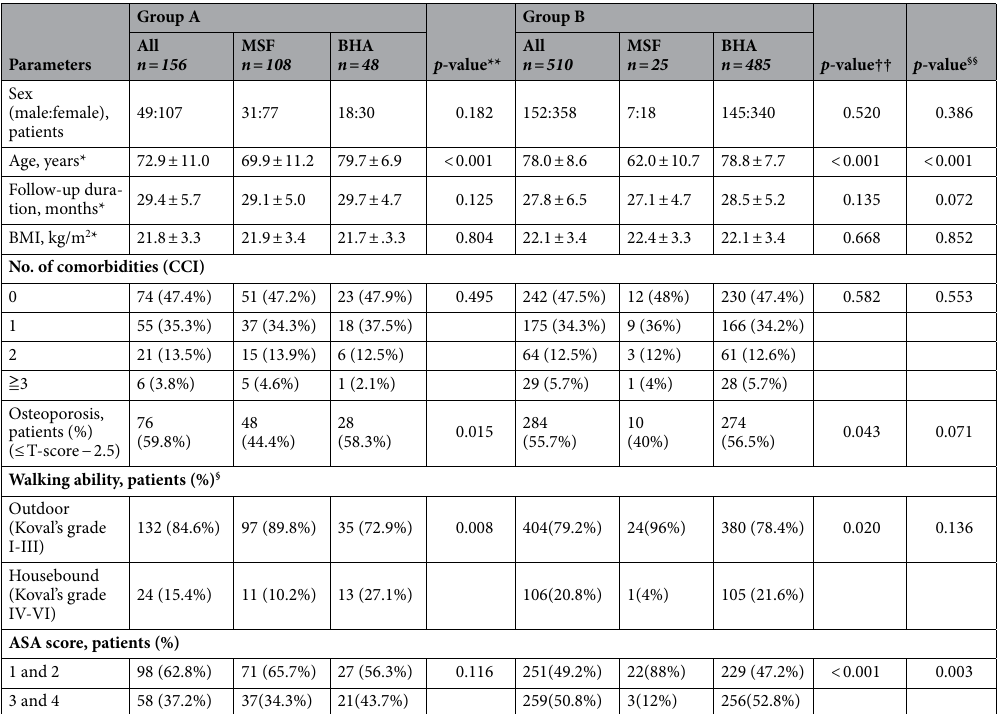
Table 1. Comparison of demographic data according to fracture pattern and type of surgery. *Expressed as average ± standard deviation. § Modified from Koval’s grade 15 . **Significance between MSF and BHA within Group A. †† Significance between MSF and BHA within Group B. §§ Significance between Group A and B. MSF, multiple screw fixation; BHA, cementless bipolar hemiarthroplasty; n , numbers; BMI, body mass index; ASA, American Society of Anesthesiologists; CCI, Charlson’s Comorbidity